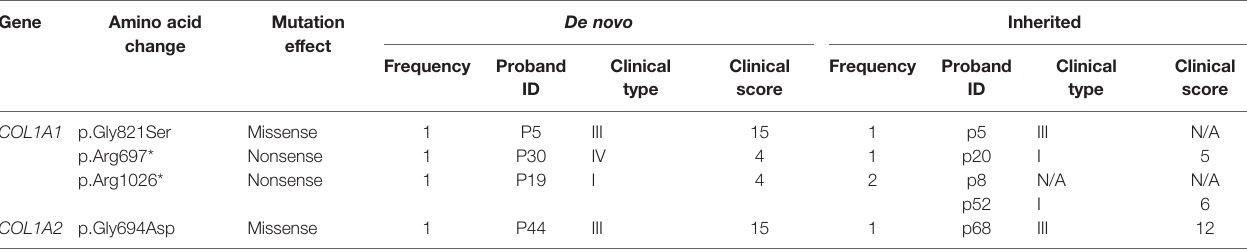
TABLE 3 | Mutations shared in de novo and inherited mutation